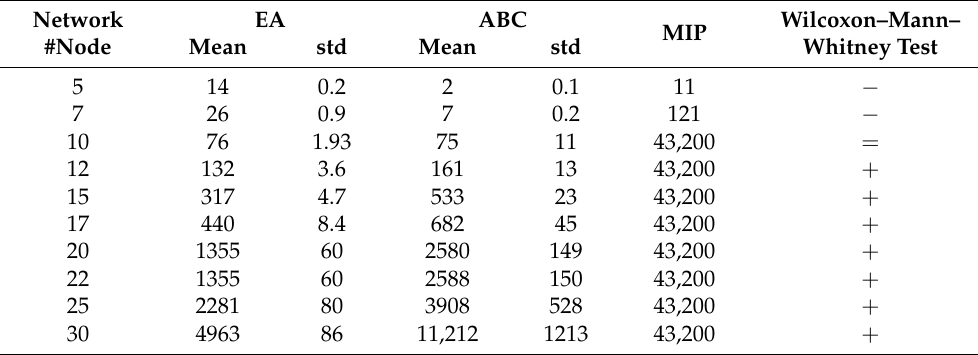
Table 4. Comparison of the computation time (sec.) together with the outcomes of the paired Wilcoxon test, for the ELP model. Symbols + , − and = indicate whether the EA algorithm was better (+), worse ( − ) or equal (=) to the ABC